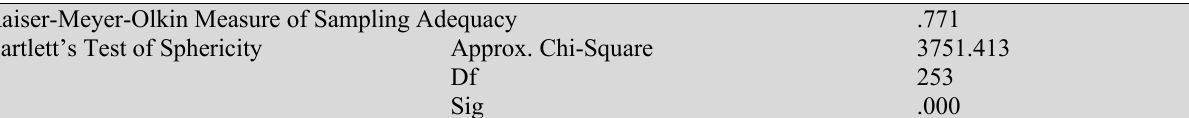
KMO and Bartlett Test Kaiser-Meyer-Olkin Measure of Sampling Adequacy